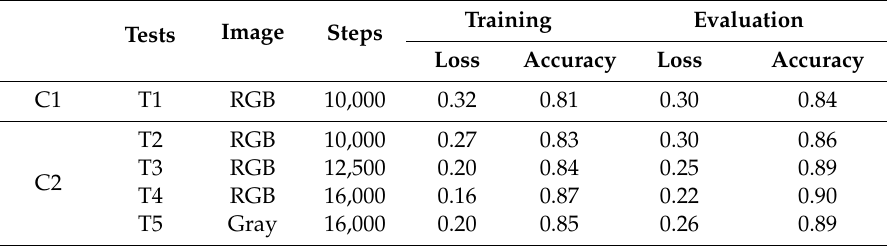
Table 2. Results obtained with the networks based on VGG Net—Using half of the